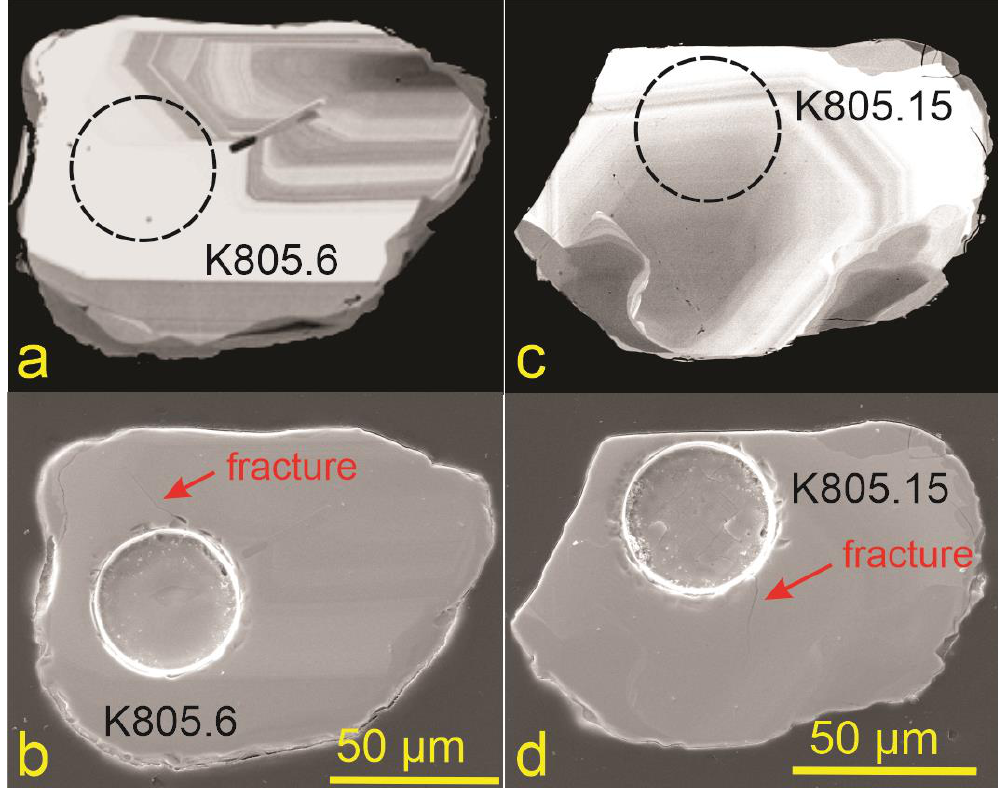
Figure 13. Backscattered electron (BSE) and secondary electron (SE) images showing that the discordant ages of some analytical spots are likely caused by the presence of fractures. ( a ) and ( b ) BSE and SE images of CGM K805.6. ( c ) and ( d ) BSE and SE images of CGM